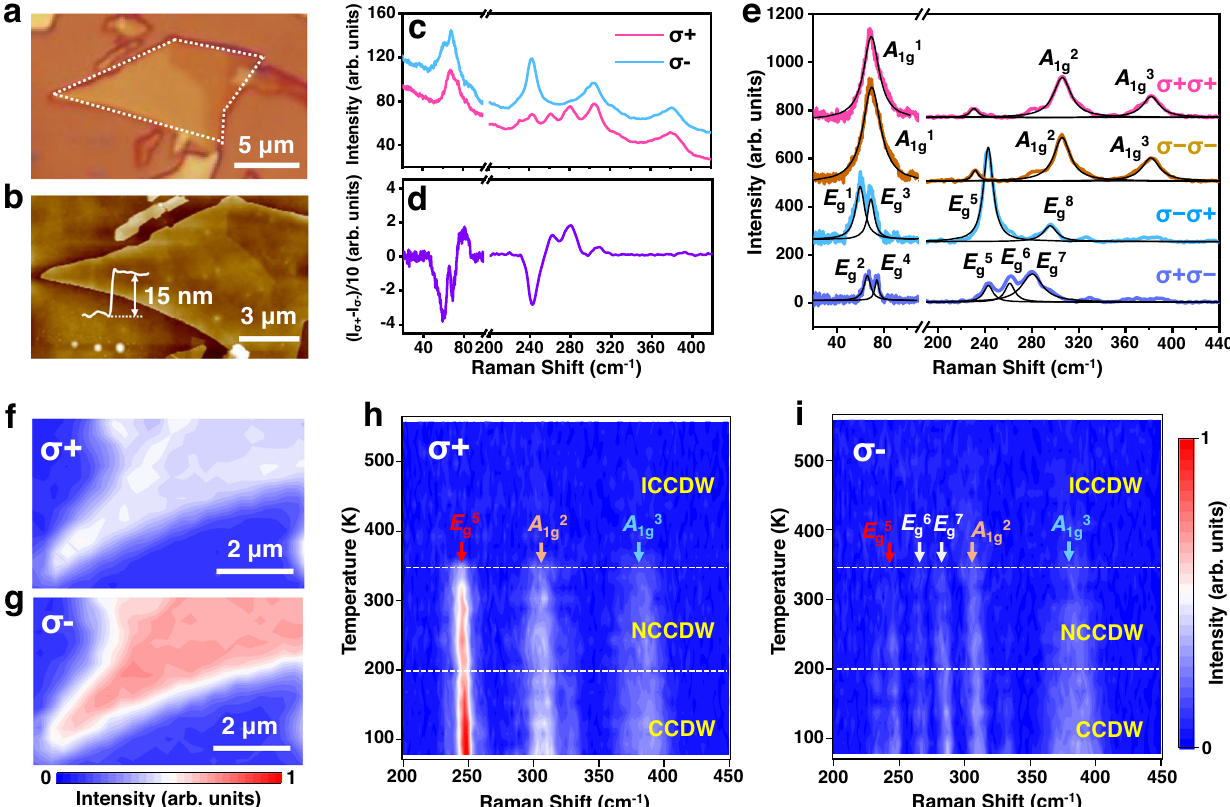
Fig. 1 | Chiral Raman response of 1T-TaS 2 and its temperature dependence. a Optical picture of mechanically exfoliated 1T-TaS 2 fl ake. b AFM image and the thickness of the 1T-TaS 2 sample. c Chiral Ramanspectraof 1T-TaS 2 excited by left- handed( σ +) and right-handed( σ − )circularly polarizedlight atroom temperature. d Raman intensity difference (I σ + – I σ − ) extracted from c after removing the back- ground. e Helicity-resolved Raman spectra of 1T-TaS 2 at room temperature. f , g Ramanintensitymapping of E g 5 modeofthe 1T-TaS 2 fl ake underthe f σ +and g σ − laser excitation. h , i False-color Ramanspectrashowing the variation of Raman